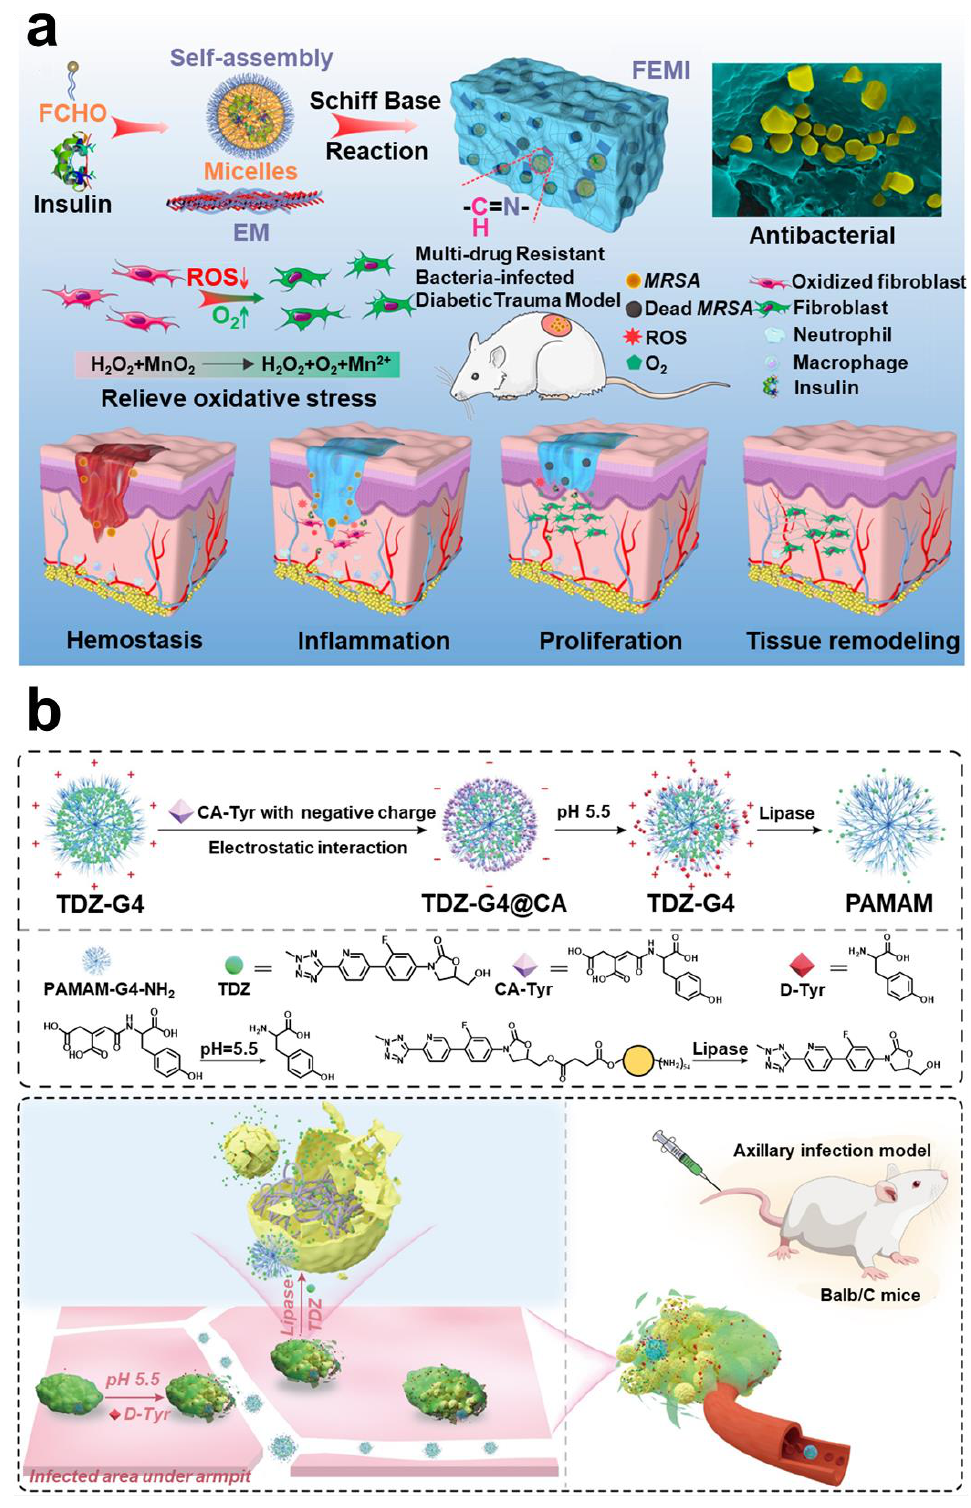
Figure 10. Using hypoxia and low pH to realize intelligent response technology. ( a ) Using Mn 2+ endogenous overexpression of H 2 O 2 to produce O 2 to solve the hypoxia. Reprinted with permission from Ref. [194]. Copyright 2020, Qiuyu Zhang. ( b ) Schematic diagram of functional group protonation in low pH environment to realize charge reversal and intelligent release strategy. Reprinted with permission from Ref. [200]. Copyright 2022, Wei Hong.